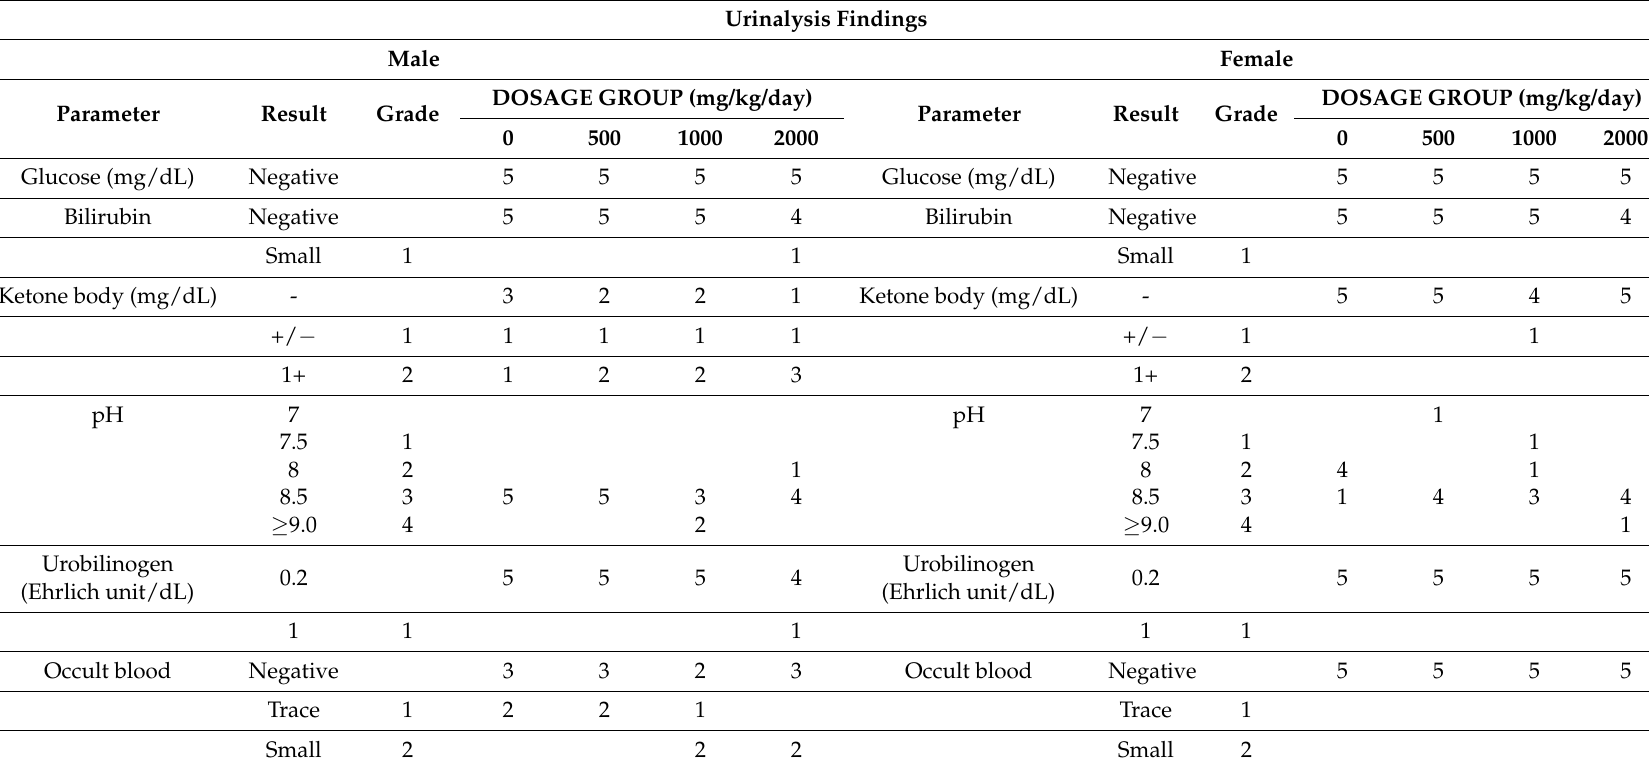
Table 9. Urinalysis findings in male and female rats given 500, 1000, or 2000 mg/kg/day GEE for 13 weeks in a repeated oral dose toxicity study. Urinalysis